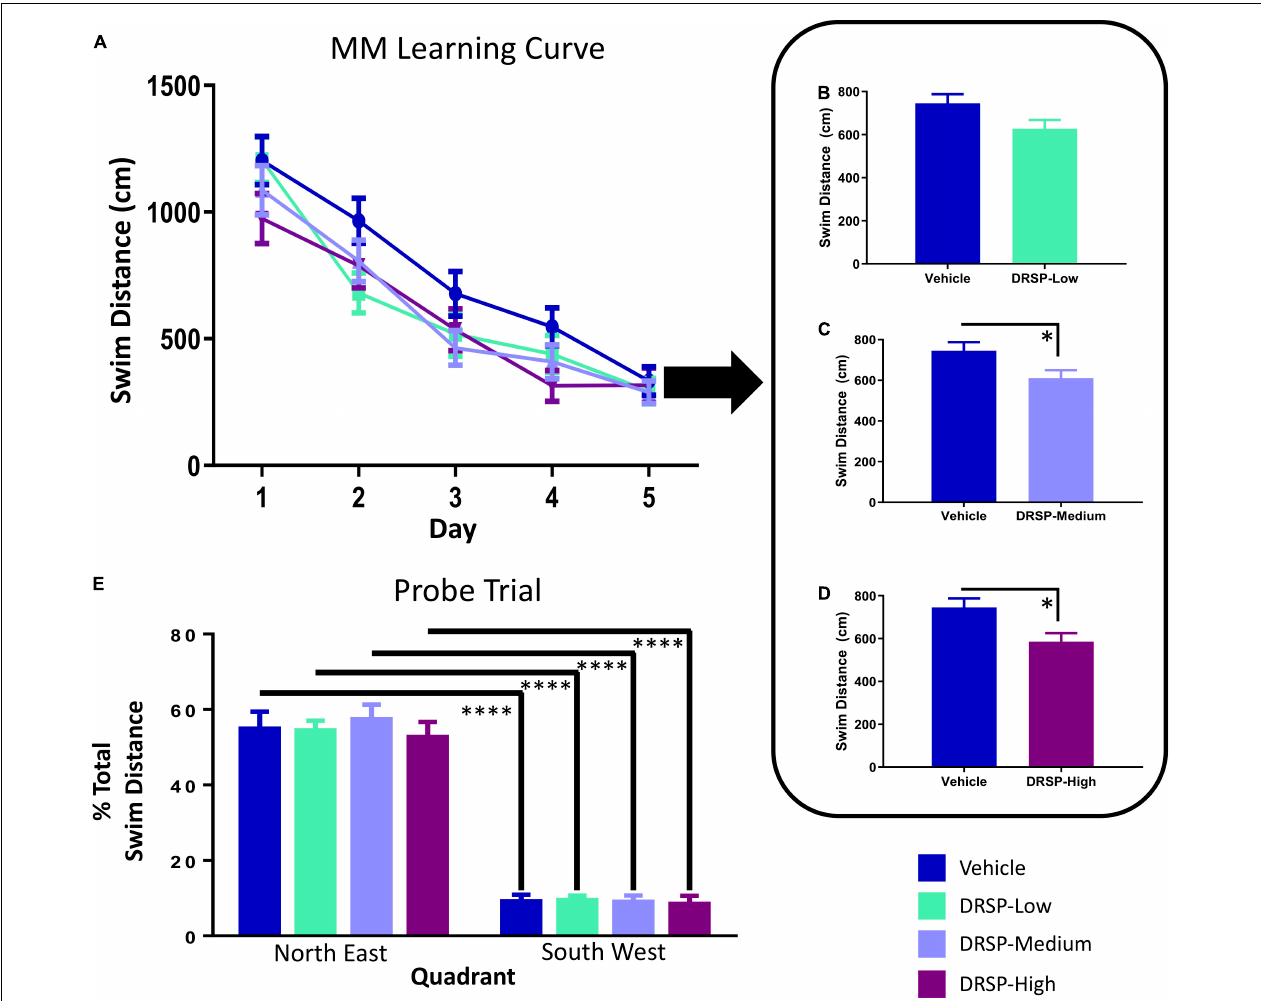
FIGURE 2 | Experiment 1 Morris water maze. Across all days of testing (A) , rats treated with the DRSP-Medium dose (C) and the DRSP-High dose (D) swam less distance to reach the platform compared to rats without hormone treatment, while the DRSP-Low group (B) performed similarly to the Vehicle group. (E) On the probe trial, all groups localized to the previously platformed target quadrant. ∗ p < 0.05 and ∗∗∗∗ p < 0.0001. Vehicle n = 10, DRSP-Low n = 10, DRSP-Medium n = 10, and DRSP-High n =